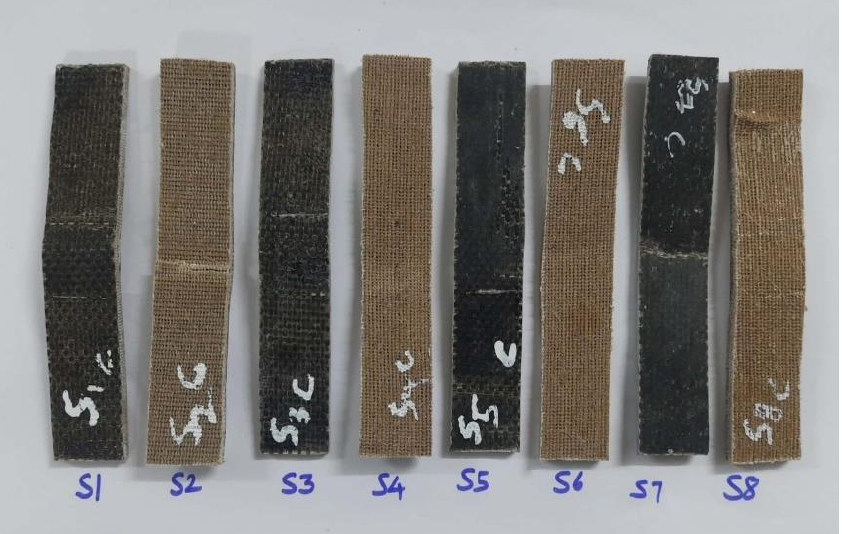
Figure 5. Flexural specimen after the test. (S1-BBBBBBBB; S2-RRRRRRR; S3-BBRRRBB; S4-RRBBBRR; S5-BRRBRRB; S6-RBBRBBR; S7-BRBRBRB; S8-RBRBRBR).